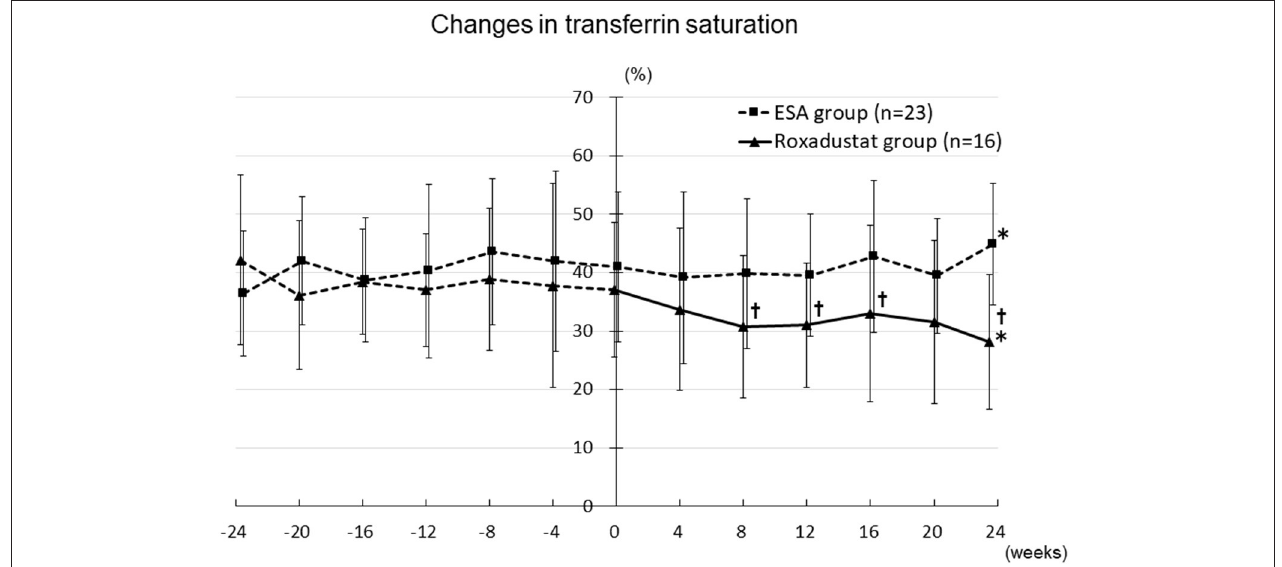
FIGURE 8 | Changes in transferrin saturation in the Roxadustat and ESA groups. ESA, erythropoiesis-stimulating agent; * p < 0.05 vs. − 24 weeks; † p < 0.05 vs. the ESA group.